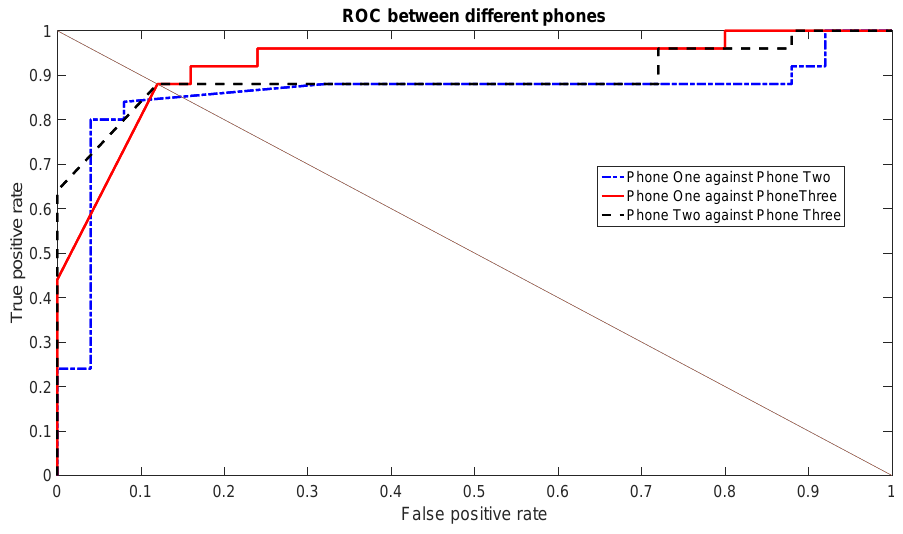
Figure 10. Receiver Operating Characteristic (ROC) among different phones using the first scenario for Gyroscope X for a single day’s data in the first set of measurements.